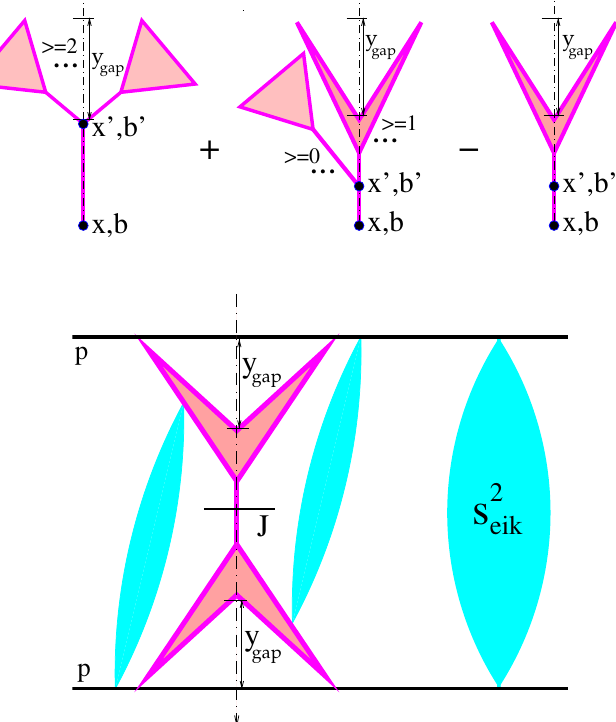
Fig. 4 Recursive equation for the contribution ( D ) ( ˆ s , b , y gap ) of 2 χ fan ( i ) diffractive cuts of fan diagrams of Fig. 3, ˆ s = s 0 / x . The cut plane is shown by the vertical dotted-dashed lines; the rapidity gaps are also indicated